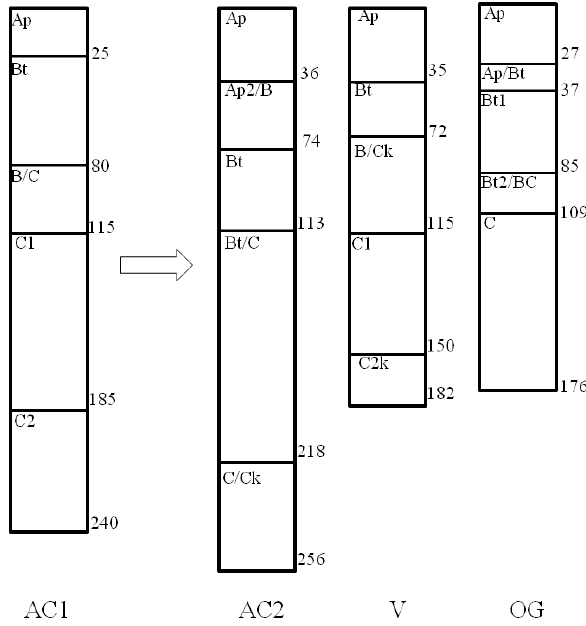
Fig. 2. Soil entire profiles. AC1 (arable crop in 1965), affect by land Figure 2. Soil entire profiles. AC1 (arable crop in 1965), affect by land use conversion (LUC) 2 use conversion (LUC) to AC2 (arable crop), V (vineyard) and OG to AC2 (arable crop), V (vineyard) and OG (olive groves). The LUC was in 1965 (AC1), after 3 (olive groves). The LUC was in 1965 (AC1), after 41 years, AC2, V and OG. (Numbers are soil the 41 years, AC2, V and OG. (Numbers are soil thickness). 4